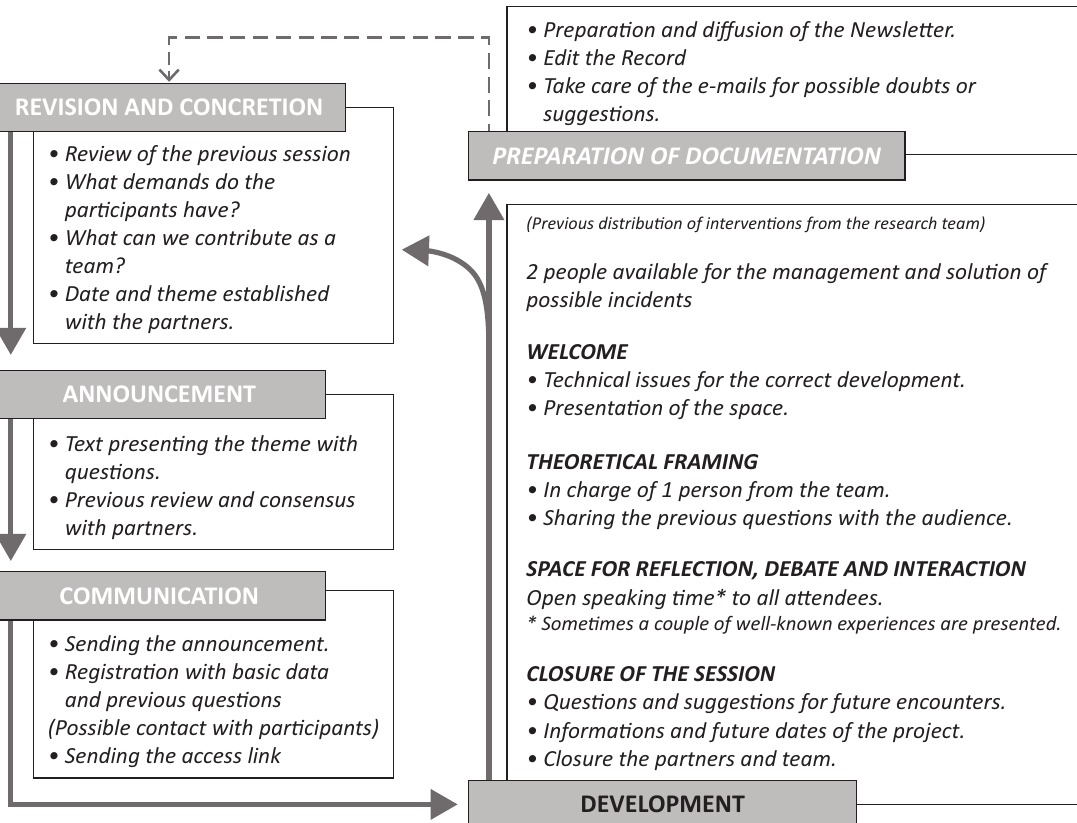
Figure 1. Reconstructed sequence of moments and actions that structure the coffee